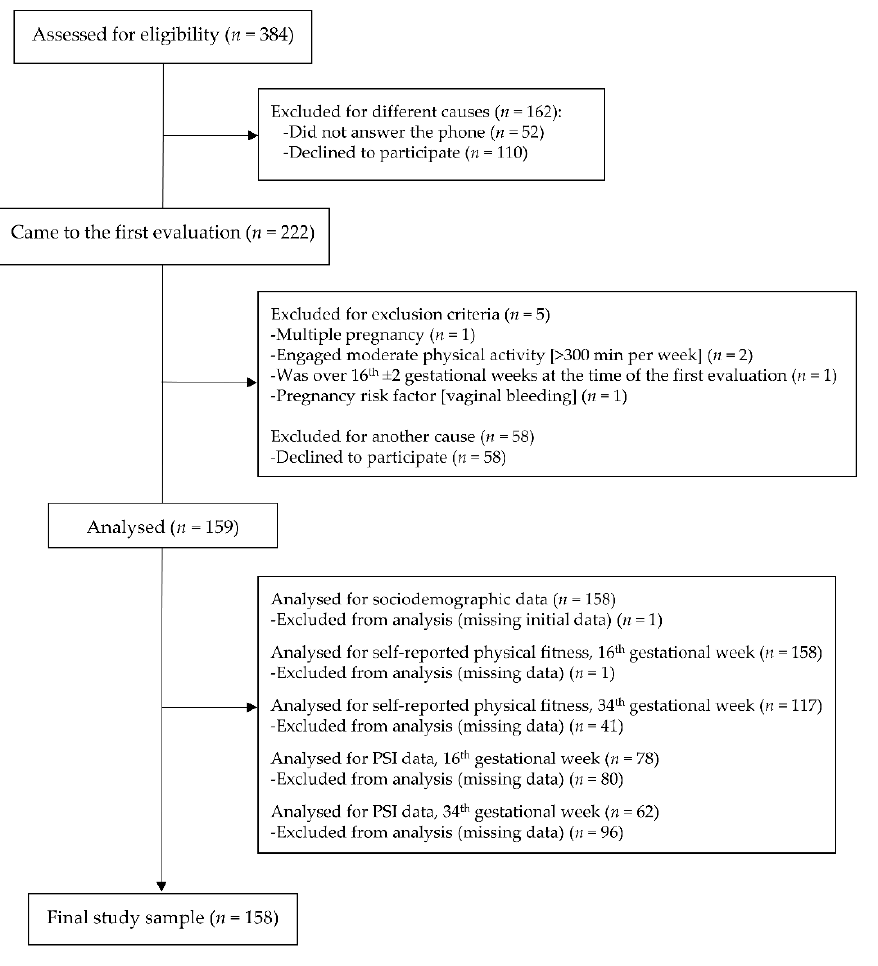
Figure 1. Flow diagram of study participants.